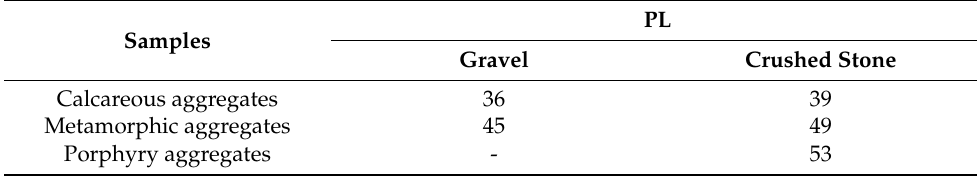
Table 13. Polishing values (PL) of the aggregates analyzed [26].